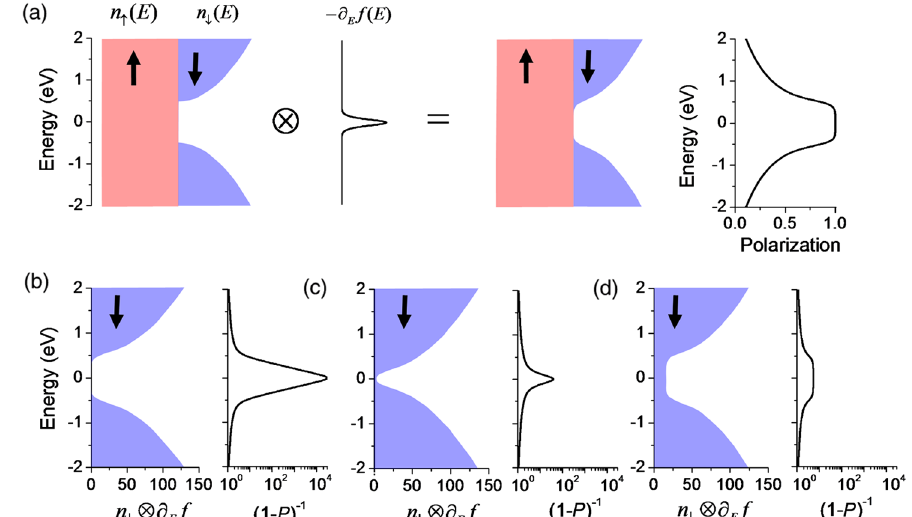
FIG. 5. Energy dependent golden-rule model. (a) Model density of states for a one-spin channel convoluted with temperature- dependent kernel with a width corresponding to T ¼ 600 K (approximately 60 meV) given by the derivative of the Fermi distribution f ð E Þ , followed by the according spin polarization P . In panels (b)–(d) the influence of the thermal excitations on the spin-flip (cid:1) @ E (cid:2) ð 1 (cid:1) P Þ (cid:1) 1 is calculated in analogy to (a) for three cases: a large gap of 1 eV (b), a small gap of 300 meV suppression factor (cid:1) el - sp FeAl ) in the spin down density of states (c), as well as for a pseudogap, representing the case of Co-Fe- (experimental value for Co 2 Ge (d). The suppression factor is given on a logarithmic